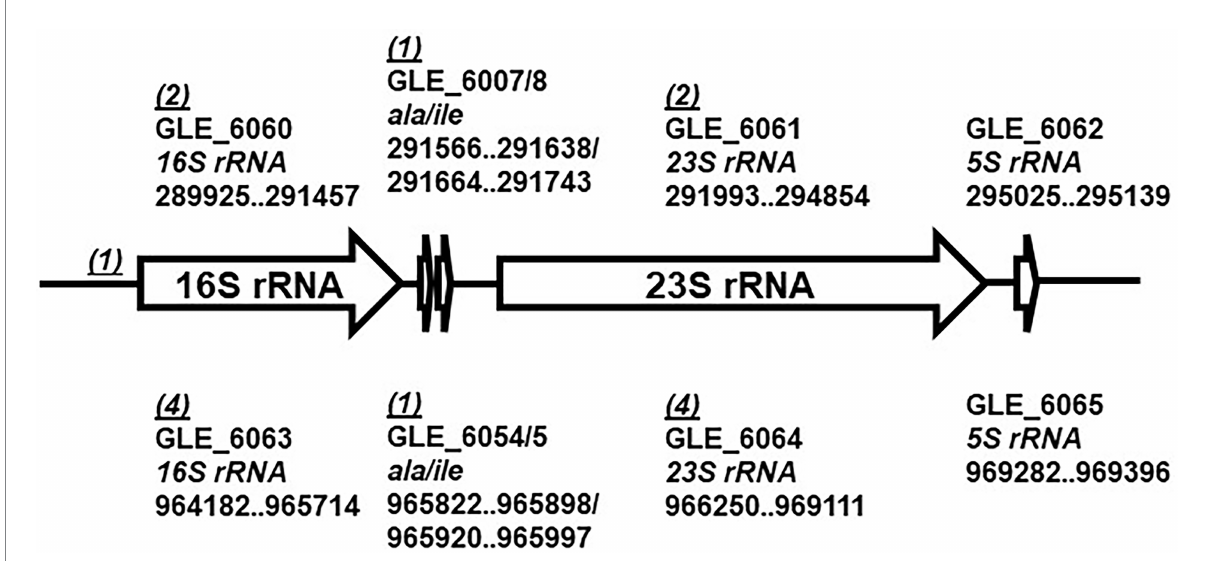
FIGURE 1 Schematic map of the two rRNA operons in Lysobacter enzymogenes . Each ribosomal RNA ( rrn ) operon contains five genes, encoding 16S rRNA ( 16S rRNA ), tRNA-Ala ( ala ), tRNA-Ile ( ile ), 23S rRNA ( 23S rRNA ), and 5S rRNA ( 5S rRNA ). Numbers in parentheses indicate numbers of mutants identified with insertions in the gene or the intergenic region (IGR). The genome sequence accession number for L. enzymogenes C3 is